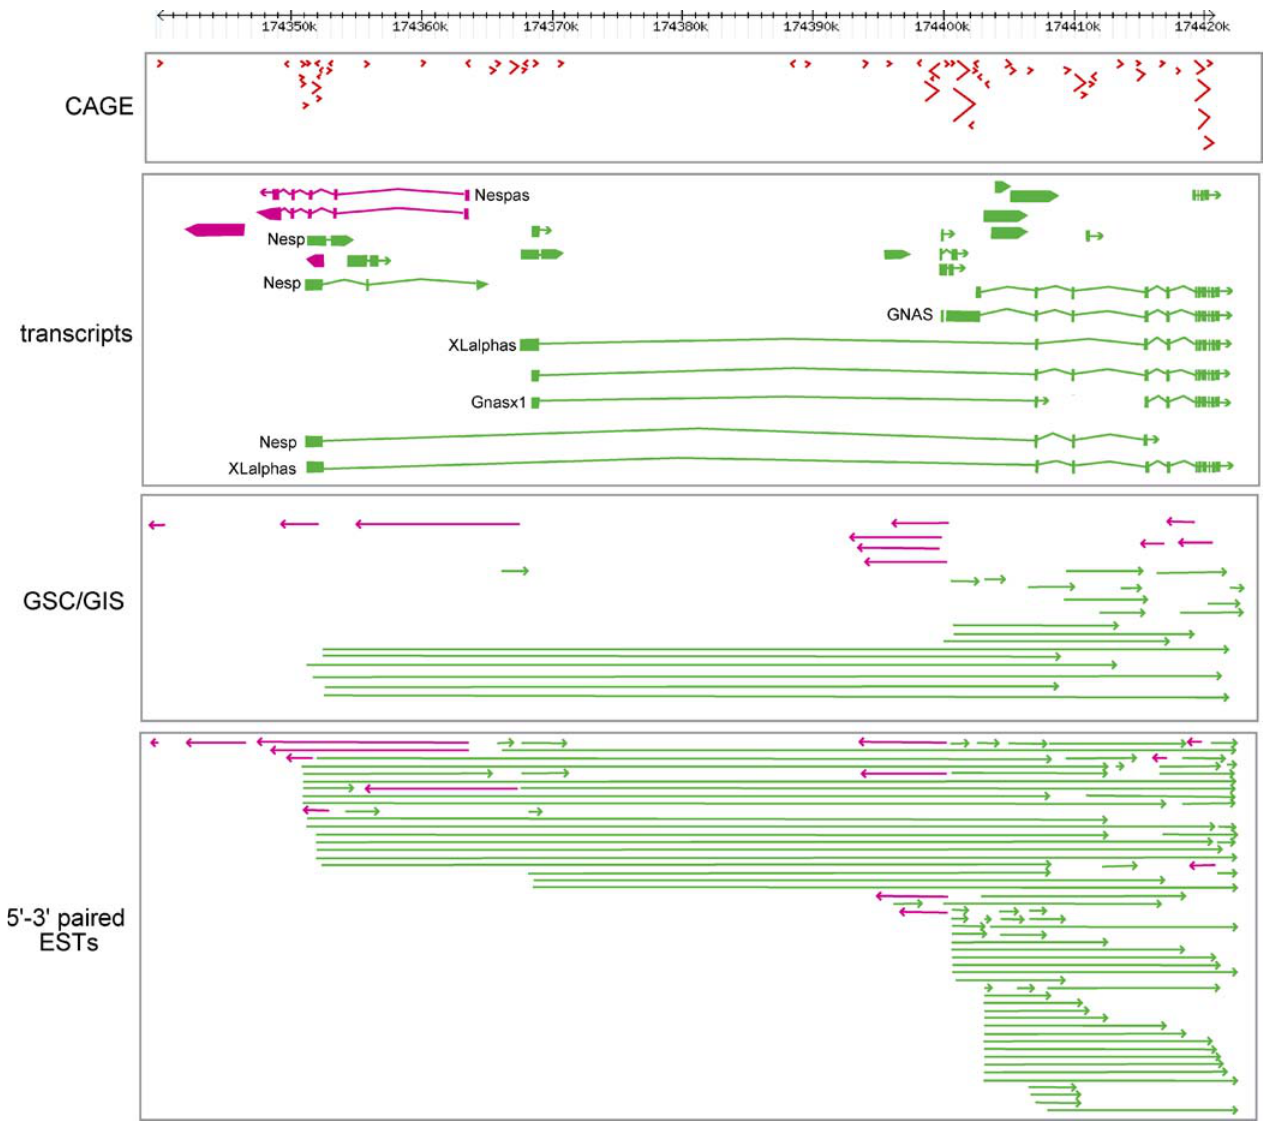
Figure 1. The Imprinted Gnas Locus Reveals the Complexity of the Transcriptome There at least 50 different transcripts that overlap into about ten interconnected TUs. The upper panel shows the CAGE tags (TSSs). Pink and green denote the two different transcript orientations on the genome. The size of the arrow corresponds to the number of overlapping CAGE tags. The middle panel shows the regions of the genome that are utilized as exons, and the structure of known transcripts, with their annotation. The bottom two panels show novel transcript boundaries, identified with gene signature cloning and gene identification of signature (GSC/GIS) and 5 9 –3 9 paired expressed sequence tags